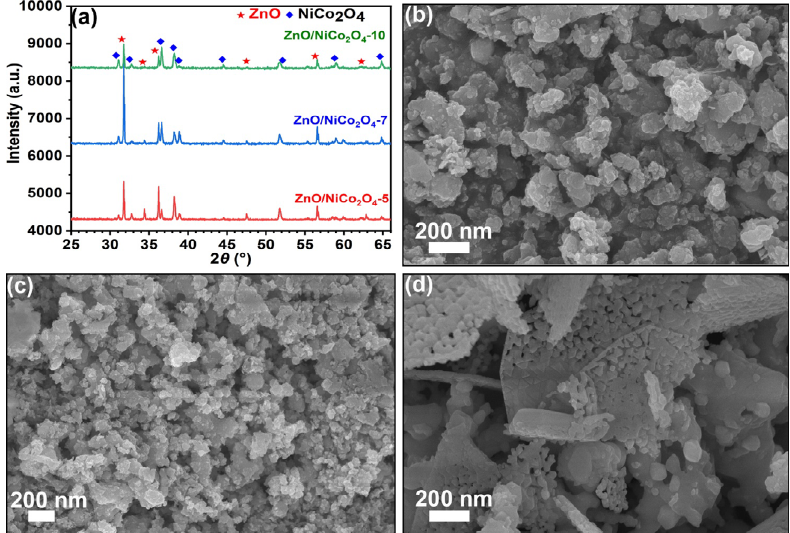
Fig. 1 (a) XRD patterns and (b–d) SEM images of the as-obtained samples: (b) ZnO/NiCo 2 O 4 -5, (c) ZnO/NiCo 2 O 4 -7, and (d) ZnO/NiCo 2 O 4